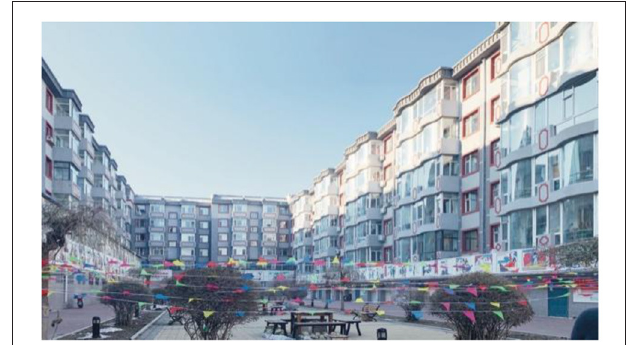
FIGURE 5 | Lianhua Mountain Shimao real estate (a) (Source: Authors).